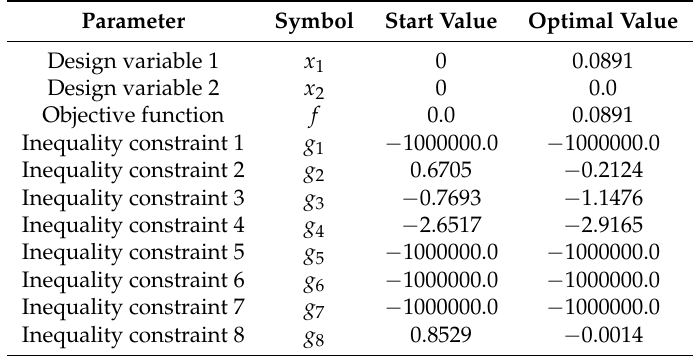
Figure 7. Convergence plot for the two-mass oscillator. Table 1. Optimization responses for the two-mass